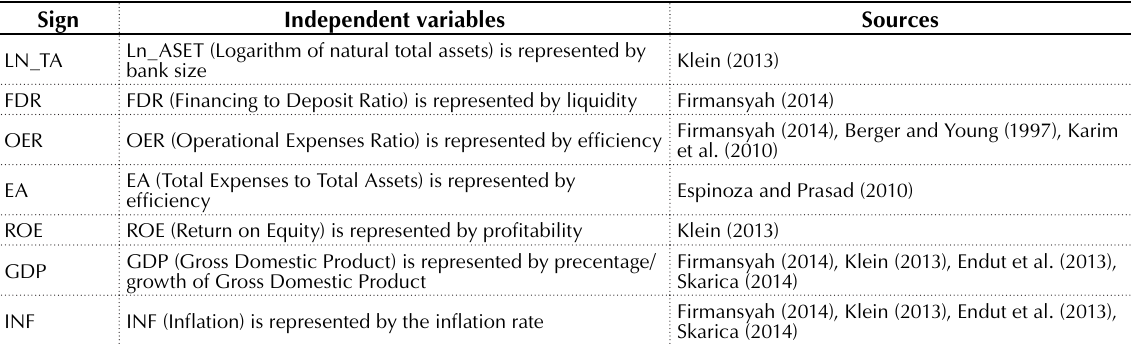
Table 1. NPF model by working